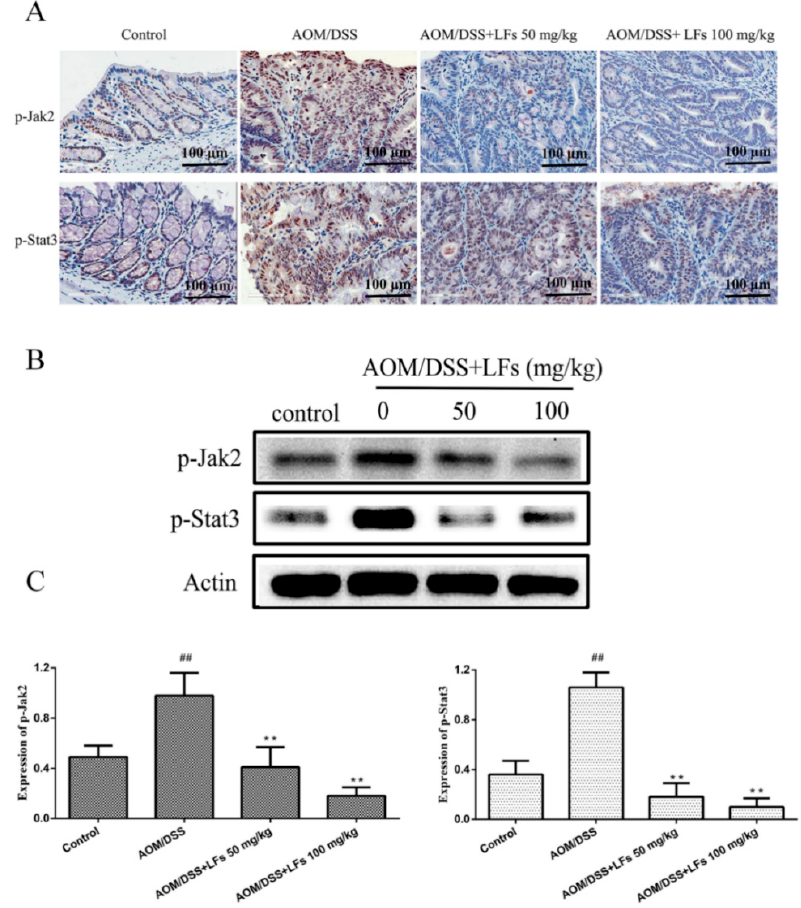
Figure 5. Effects of LFs on phosphorylation of Jak2 and Stat3: ( A ) Immunohistochemical staining of p-Jak2 and p-Stat3 in colonic tissues; and ( B , C ) Western blot of p-Jak2 and p-Stat3 expression in colonic tissues and semi-quantitative analysis of these proteins. Data are presented as mean ± SD. ** p < 0.01 vs. model, ## p < 0.01 vs. vehicle